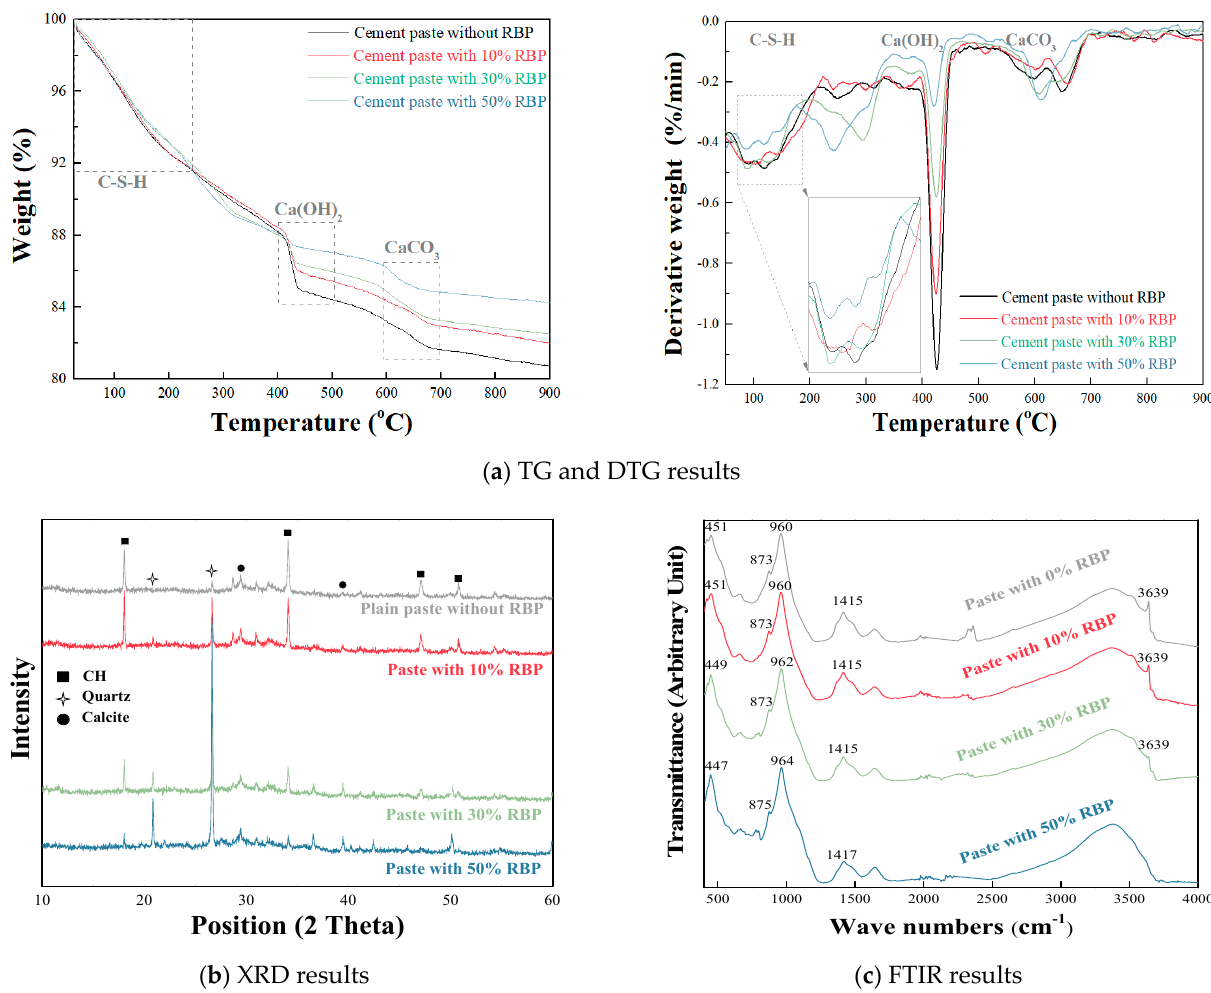
Figure 6. Hydration products and mineral composition of paste with various RBP substitution rates.